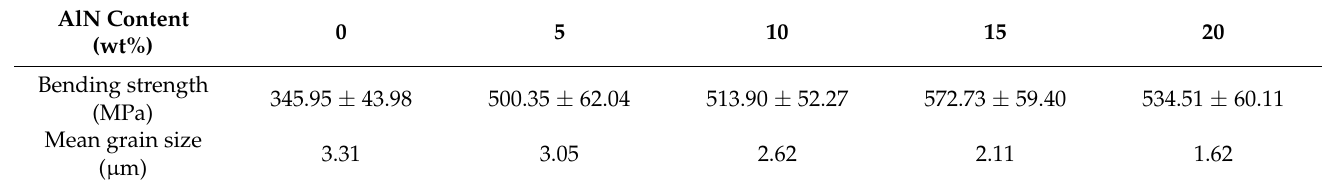
Figure 7. Microstructure and grain size distribution at 1650 °C 2 h: ( a ) 0 wt% AlN; ( b ) 5 wt% AlN; ( c ) 10 wt% AlN; ( d ) 15 wt% AlN; ( e ) 20 wt% AlN. Table 3. Bending strength and mean grain size of Al 2 O 3 -AlN composites at 1650 °C for 2 h.